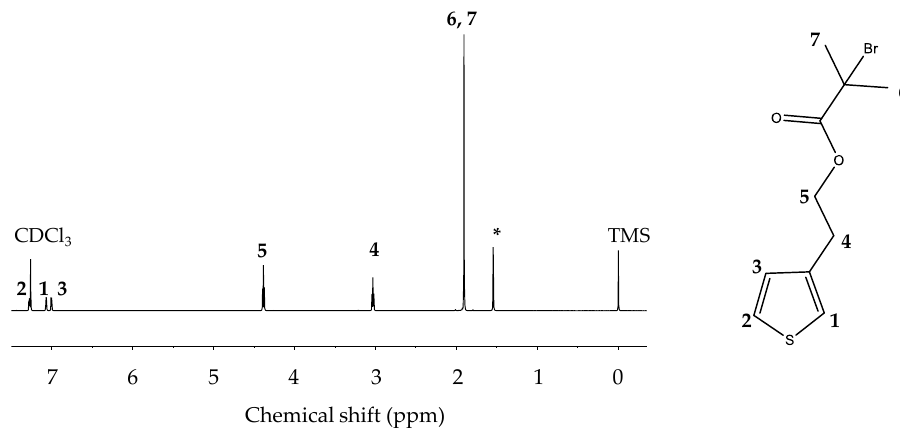
Figure 3. 1 H NMR spectrum of ThBr monomer.